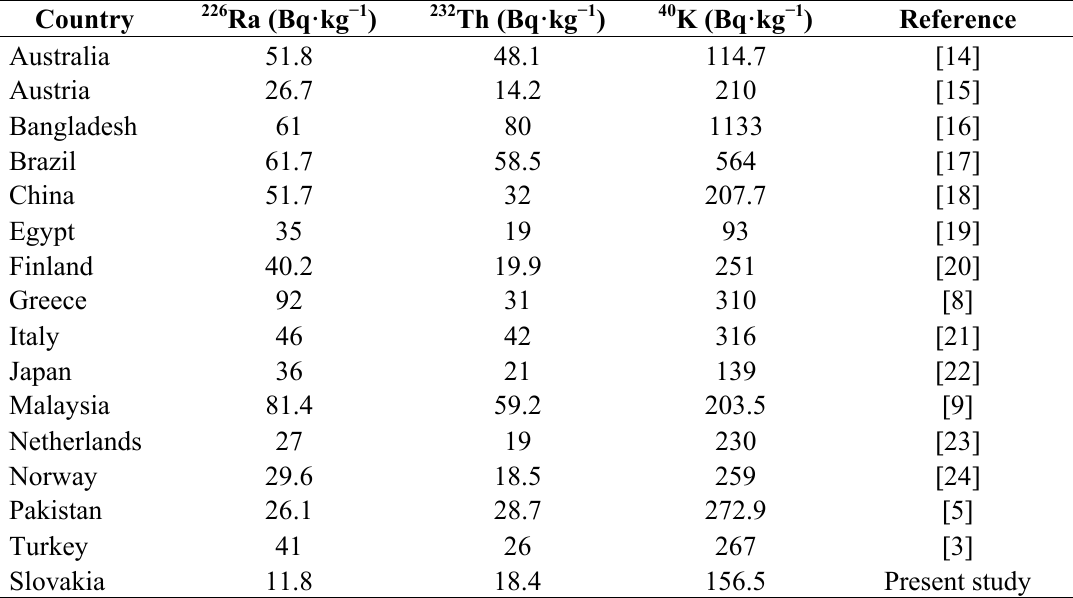
Table 5. Comparison of specific gamma activities (Bq·kg − 1 ) of the Slovak Portland cement samples with that of other countries of the world.